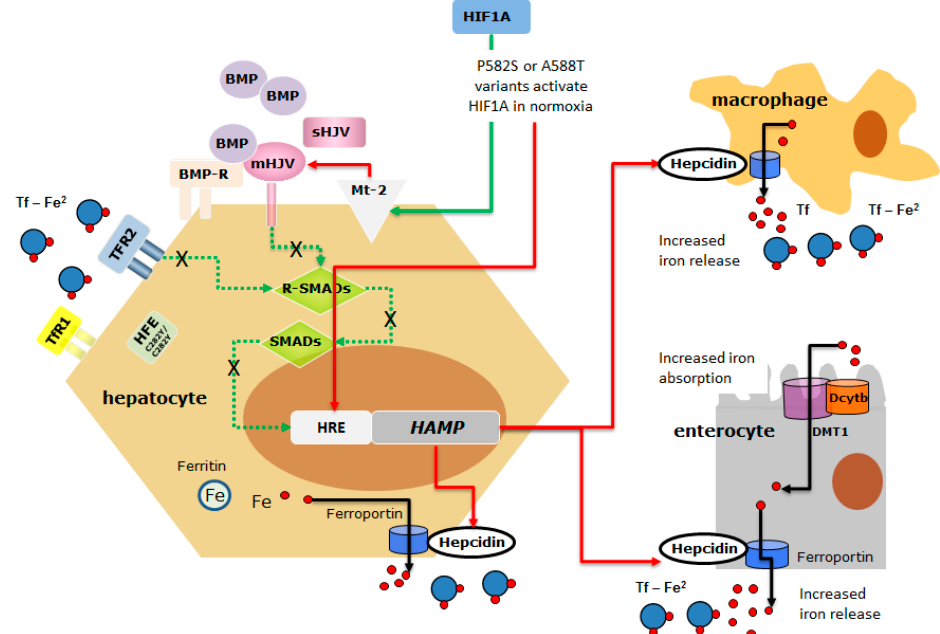
Figure 3. The schematic representation of the possible interaction between HIF1A variants and the HFE C282Y/C282Y mutant protein in inducing hepcidin suppression. HFE is a component of an iron-sensing complex that involves interactions with diferric transferrin (Tf-Fe 2 ), transferrin receptors (TFR-1 and TFR-2) at the plasma membrane of hepatocytes. High concentrations of Tf–Fe 2 displace HFE from TFR1, which then forms a complex with TFR2 and HJV to promote bone morphogenetic protein (BMP)/SMAD signaling to hepcidin. HJV is a GPI-linked protein that activates hepcidin as a co-receptor for BMP cytokines. The regulatory SMADs (R-SMADs), SMAD1, SMAD5, and SMAD8 are the mediators of BMP signaling, as they are phosphorylated by activated BMPRs. The common SMAD4 translocates to the nucleus in the complex with the R-SMADs to induce the expression of hepcidin. BMP/SMAD signaling to hepcidin is suppressed by matriptase 2 (Mt-2), a serine protease, codified by TMPRSS6 which cleaves and generates a soluble form of HJV (sHJV). Homozygous p.Cys282Tyr mutation affects HFE function limiting its expression on the membrane, thus dysregulating the iron-sensing complex and leading to HAMP downregulation. HIF1A p.Phe582Ser and p.Ala588Thr variants that stabilize HIF1A in normoxia might further inhibit hepcidin expression acting directly on the HAMP Hypoxia Responsive Element (HRE) or indirectly through the activation of Mt-2 [40,49] (the red arrow indicates inhibitory action; the green arrow indicates activating action; dotted green line indicates the signaling pathways dysregulated by HFE C282Y/C282Y mutant protein and HIF-induced Mt-2 activation).